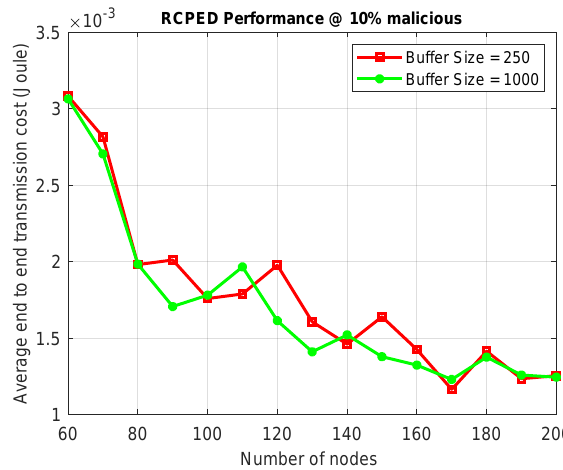
Figure 8. RCPED performance with different buffer size.